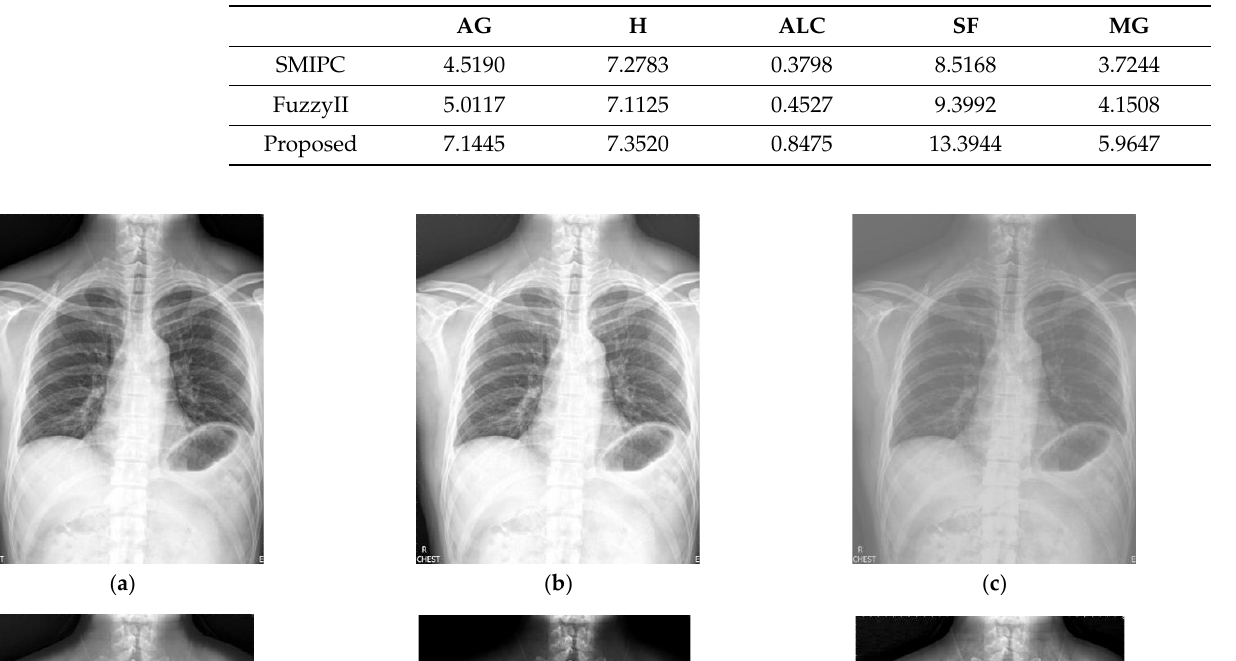
( i ) Figure 3. Comparison on X-ray image 3. ( a ) Original image; ( b ) McCann; ( c ) RLBHE; ( d ) RESIHE; ( e ) TBCSSR; ( f ) GDGIF; ( g ) SMIPC; ( h ) FuzzyII; ( i ) Proposed method. Table 3. The metric data of eight methods on X-ray image 3. AG